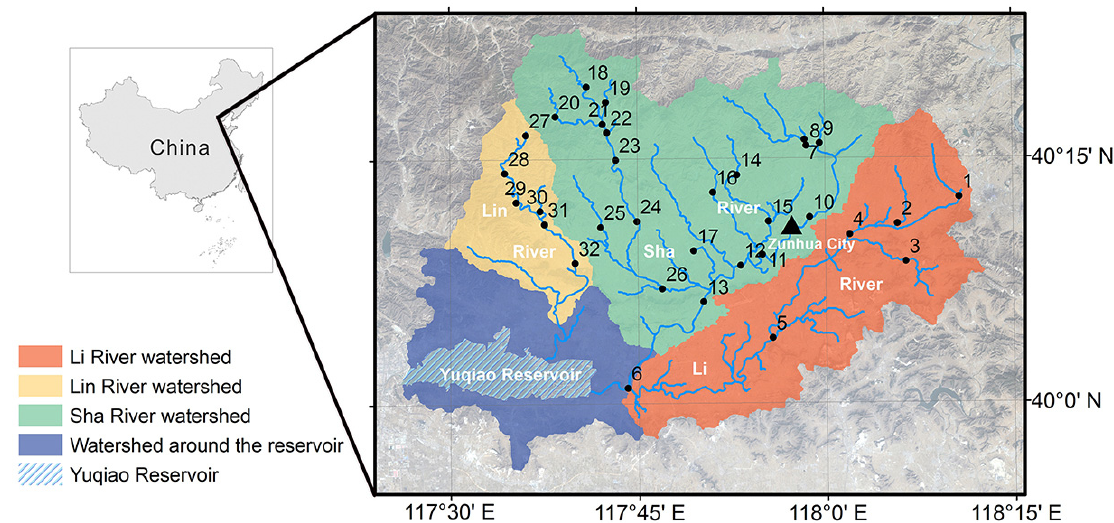
Figure 2. Study area and sampling locations.